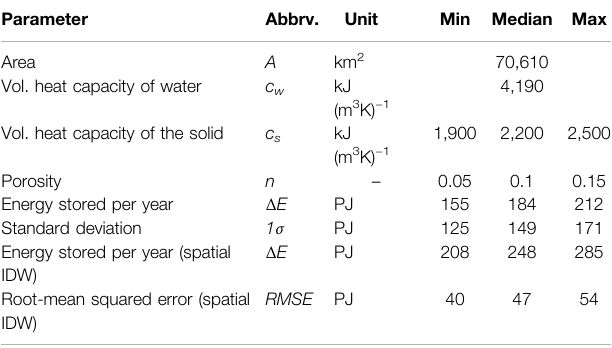
TABLE 1 | Heat content model parameters for the minimum, medium, and maximum scenario. Parameter